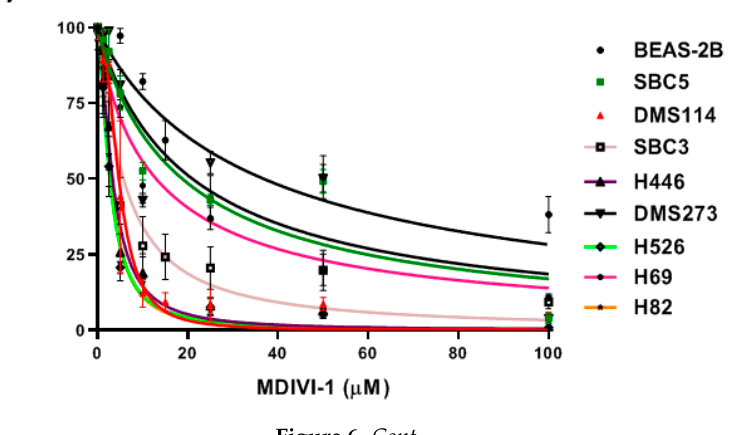
Figure 6. Cytotoxicity of SCLC cell lines to mdivi-1 and cisplatin. SCLC and control cells in 1% serum media were treated with increasing concentrations of (a) mdivi-1 and (b) cisplatin as indicated for 72 h, and cell viability was then assessed via calcein-AM uptake, as described. The results were normalized as a percentage of the DMSO treated controls and analyzed via a sigmoidal dose response curve using Prism software (version 5.0) to calculate the EC 50 value for each drug. Three independent replicate experiments were performed for each experiment. Table 1. EC 50 value for various SCLC cell lines. Drug EC 50